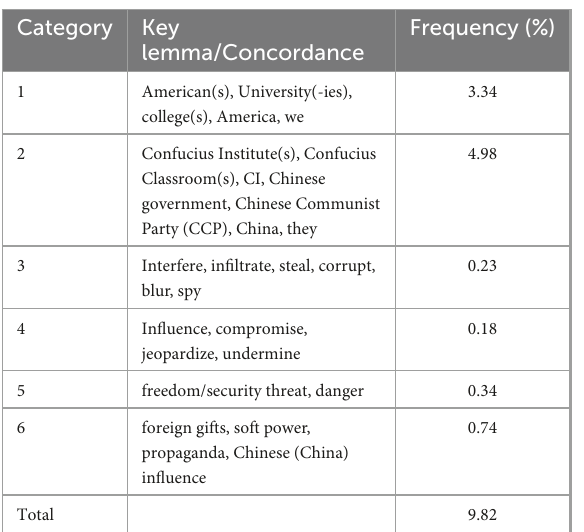
TABLE 3 The key lemmas of the spatial framework of the Confucius Institute rhetoric,